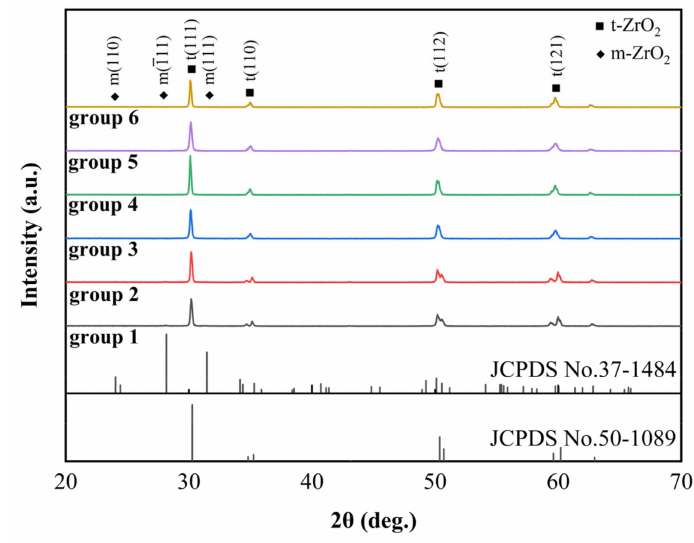
Figure 2. XRD pattern of the as-sprayed